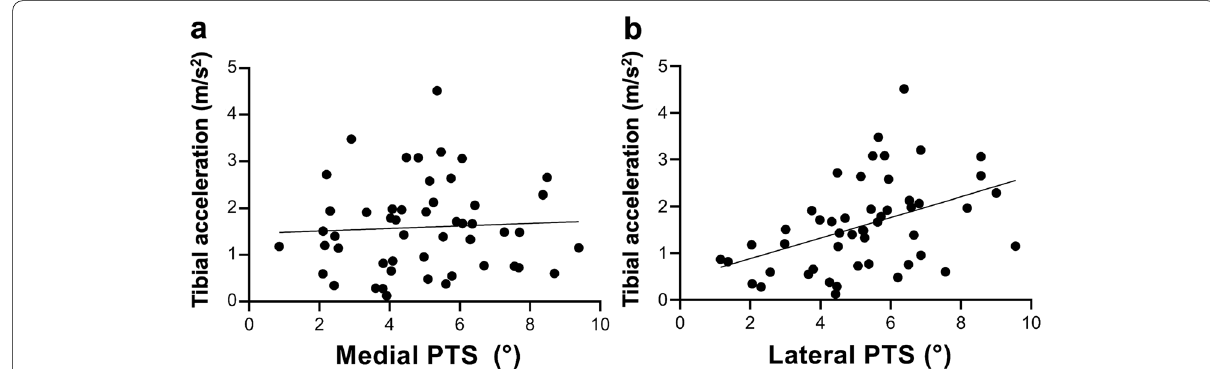
Fig. 3 Correlation between posterior tibial slope (PTS) and tibial acceleration during the pivot-shift test. a No significant correlation was observed between preoperative tibial acceleration and medial PTS ( r p <